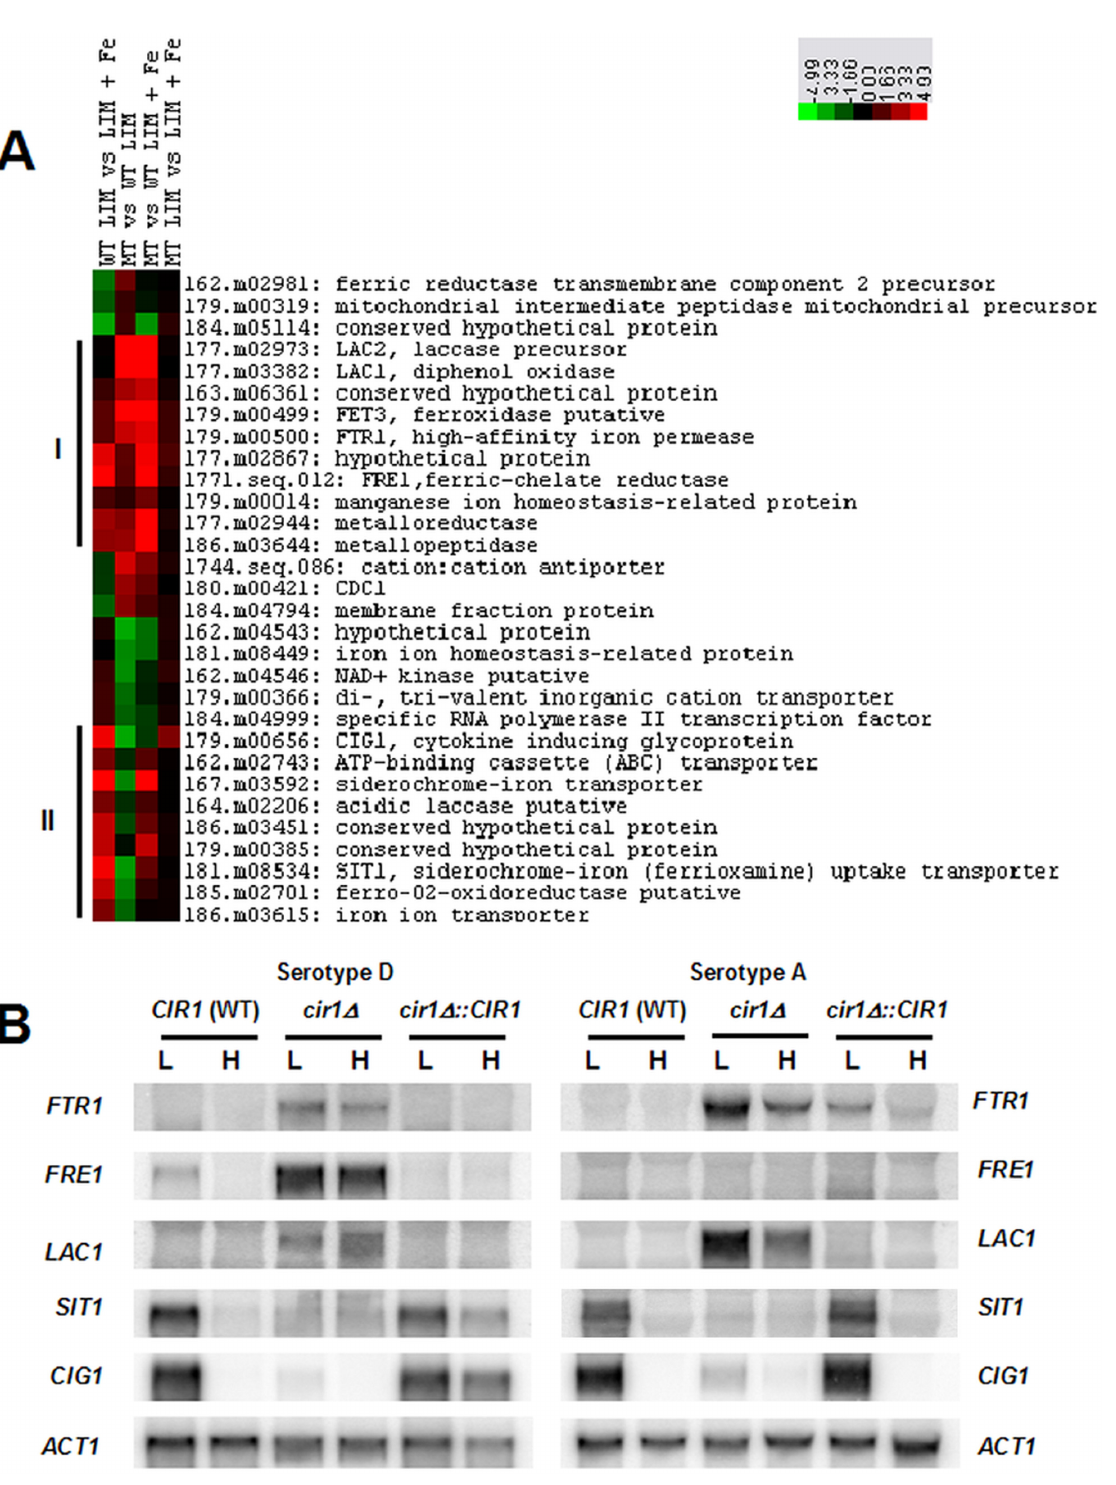
Fig 2. Cir1 Directly Regulates Genes Required for Iron Transport. (A) Cluster analysis of genes required for iron transport show two patterns of differential expression in the cir1 mutant (serotype D), resulting in two main clusters (I and II). Columns represent the log-transformed ratio of the array data from the wild-type strain in low- versus high-iron medium (WT LIM vs. LIM + Fe), the cir1 mutant versus the wild-type strain in low-iron medium (MT vs. WT LIM), the cir1 mutant versus the wild-type strain in high-iron medium (MT vs. WT LIM + Fe), and the cir1 mutant in low- versus high-iron medium (MT LIM vs. LIM +